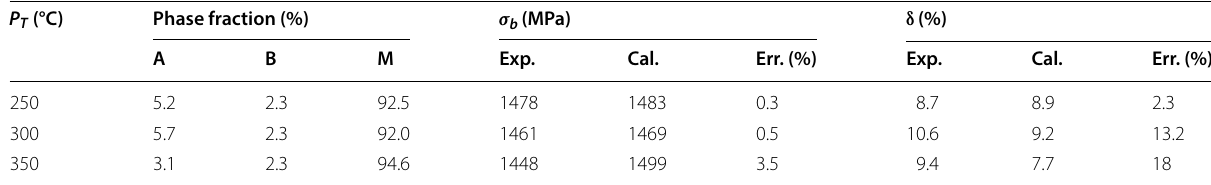
Table 4 Comparison between experimental and calculated phase fraction and mechanical properties for the side of a U-cap part